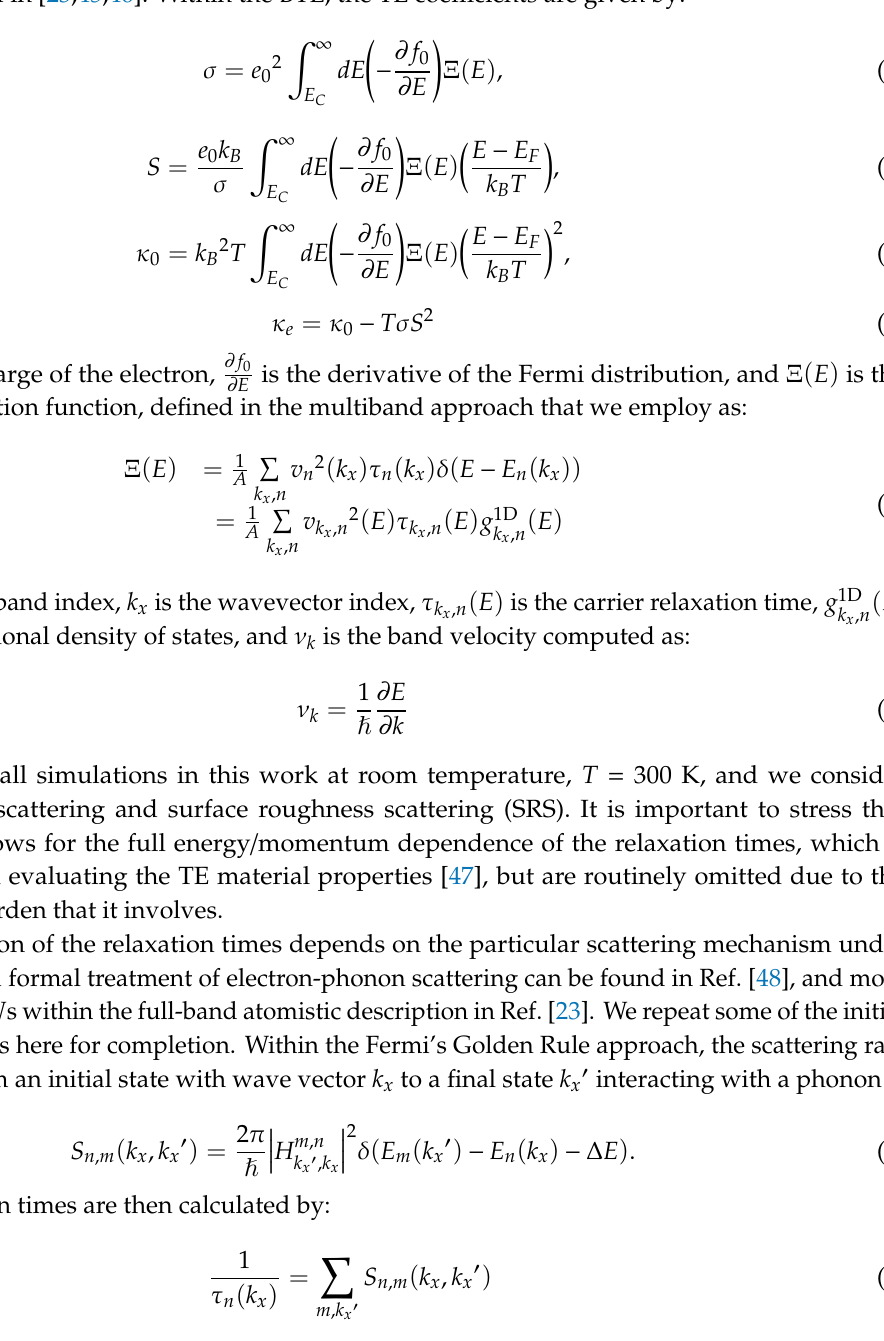
edge of the nanowires versus their diameter. Nanowire orientations in [100] (blue—circle lines) and in [110] (orange—triangle lines) are shown. The insets show the corresponding mass variation and band edge di ff erential changes for Si nanowires, as shown in Refs [42,44], which indicate less variation for both